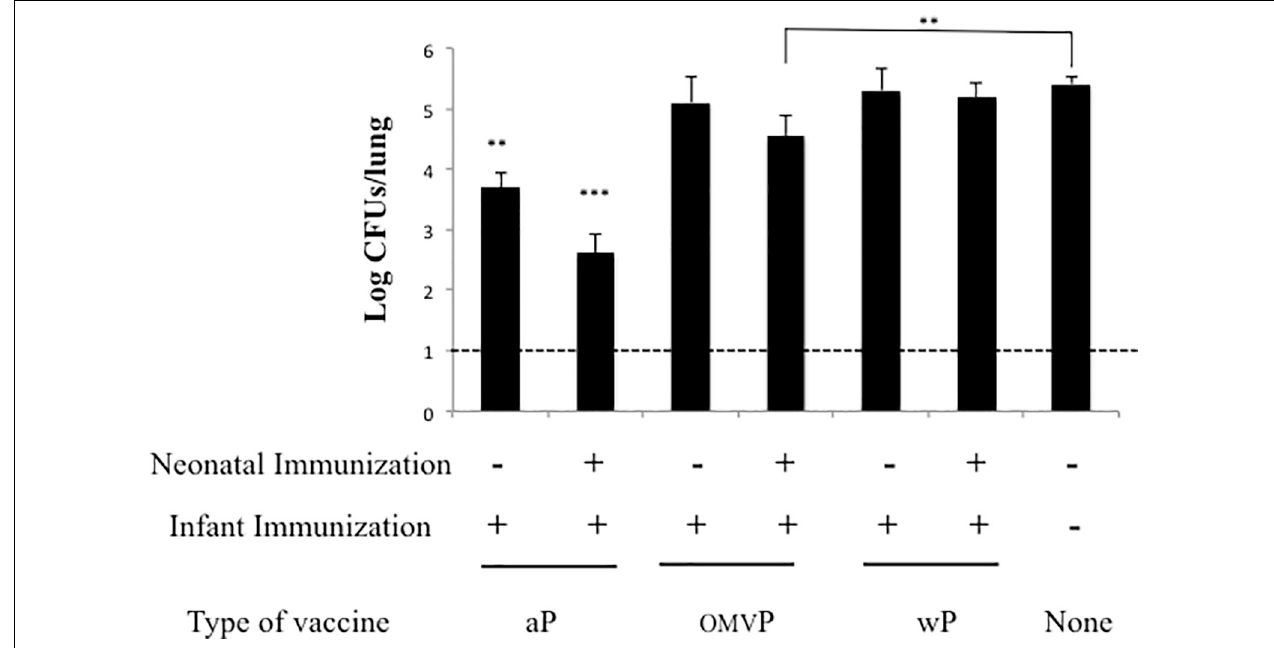
FIGURE 2 | Effect of neonatal immunization on the first dose administered during the infancy. The infant doses were administered in both immunized or non-immunized mice at 21 days during the neonatal period in either the presence or the absence of a neonatal dose at 7 days of age. In the neonates immunized (upper indications on the abscissa ), the type of vaccine used was the same as that administered during infancy (lower indications on the abscissa ). The non-immunized mice were used as a negative control of protection. All the groups of mice ( n = 8) were challenged with B. pertussis at 35 days after birth. The number of bacteria recovered from mouse lungs, expressed as the log 10 (CFUs per lung), is plotted on the ordinate for the type and vaccine schedule indicated on the abscissa , with the data representing the means ± the SD. The dotted horizontal line indicates the lower limit of detection. ∗∗∗ p < 0.001, ∗∗ p < 0.05.